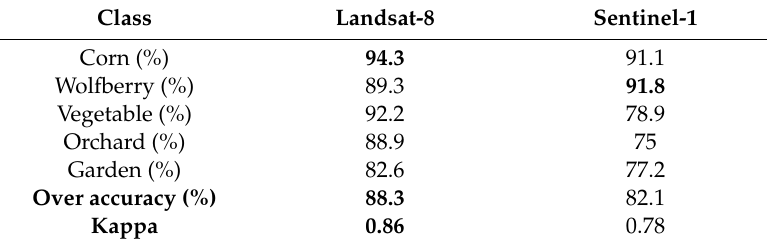
Table 2. Accuracy assessment of the crop classification results.